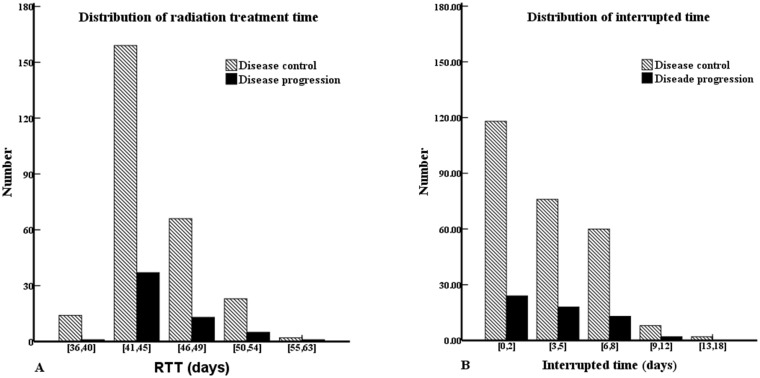
Histogram of (A) radiation treatment time and (B) interrupted time according to whether or not patients experienced disease failure.